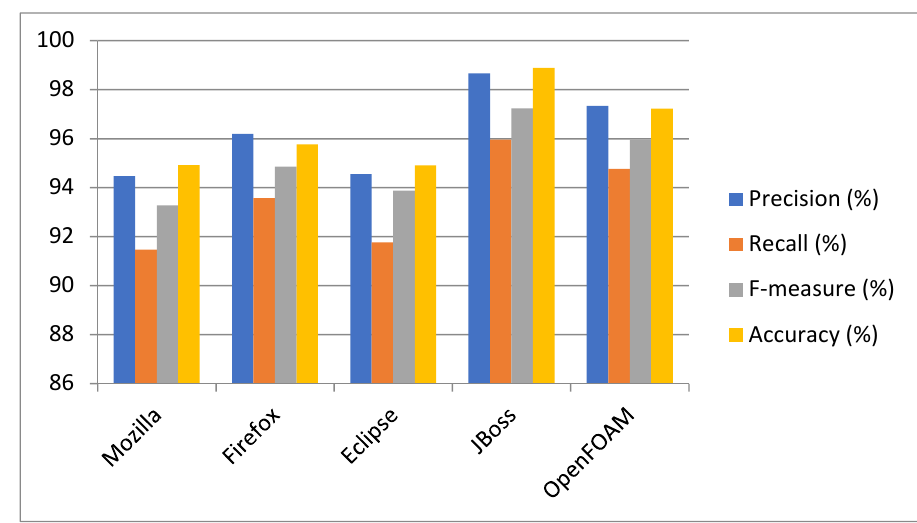
Figure 9. Result analysis of the proposed BCR on seven classes of the OpenFOAM Project .